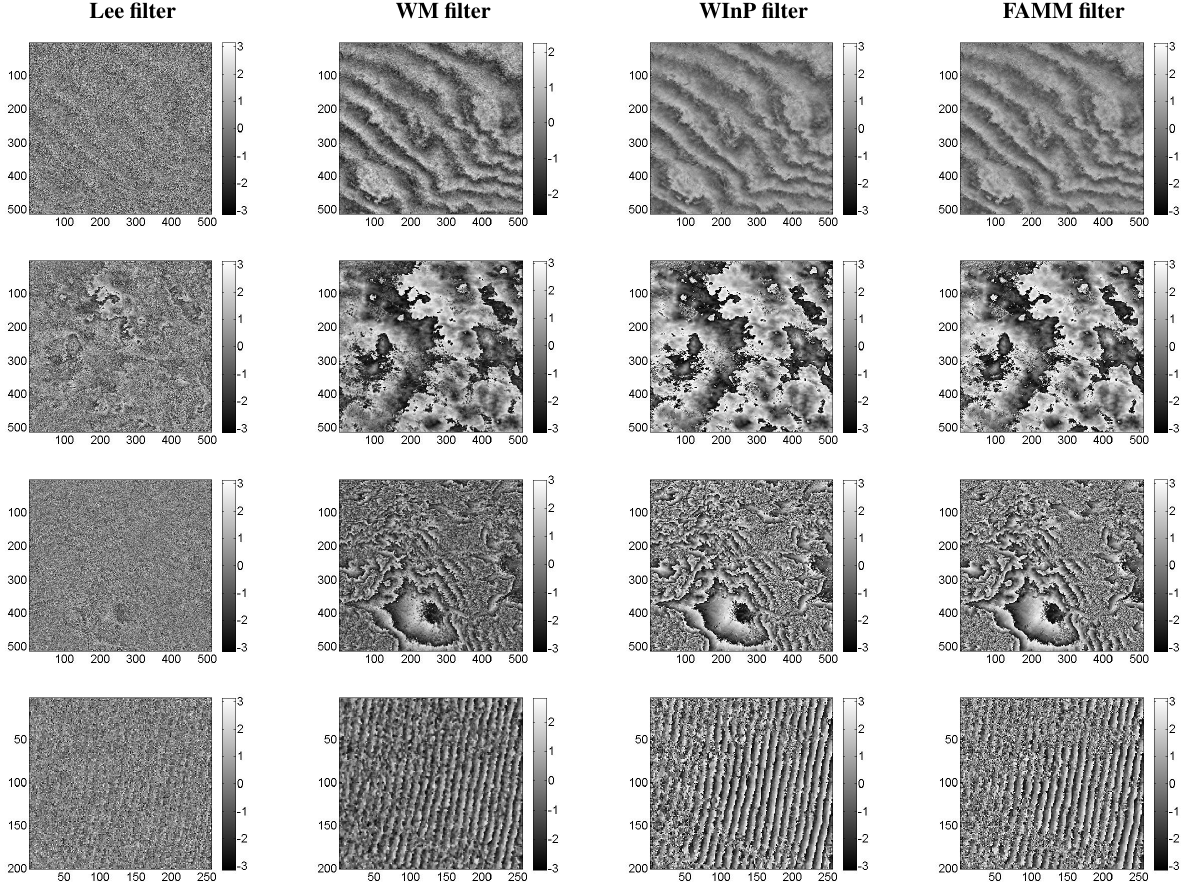
Figure 1: Filtering result of real interferograms generated from SLC data of the four satellites and acquired over the region of Mahdia : Radarsat-2 (first row) and Envisat (second row) and over the region of Ben Guerden : ERS-2 (third row) and COSMO-SkyMed (fourth